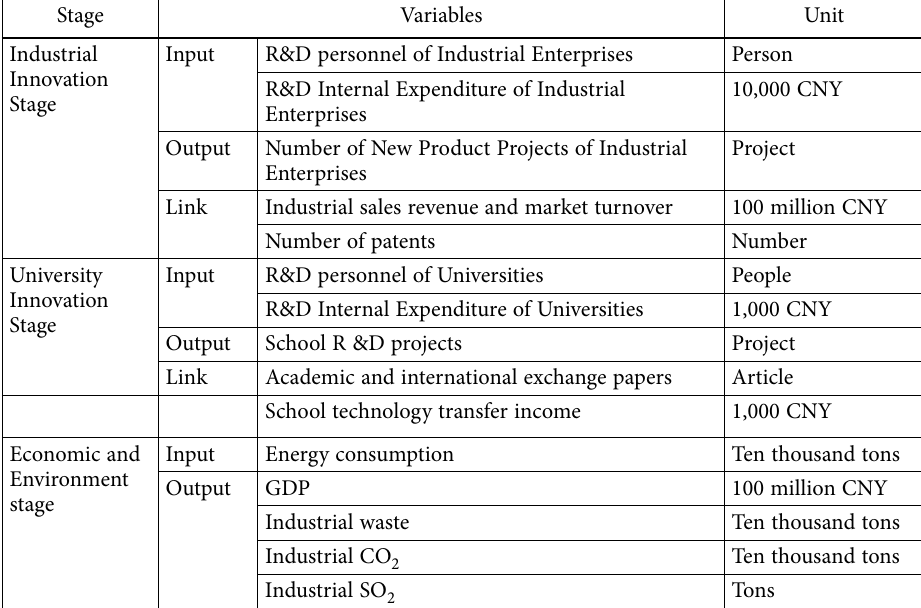
Table 1. Input and Output